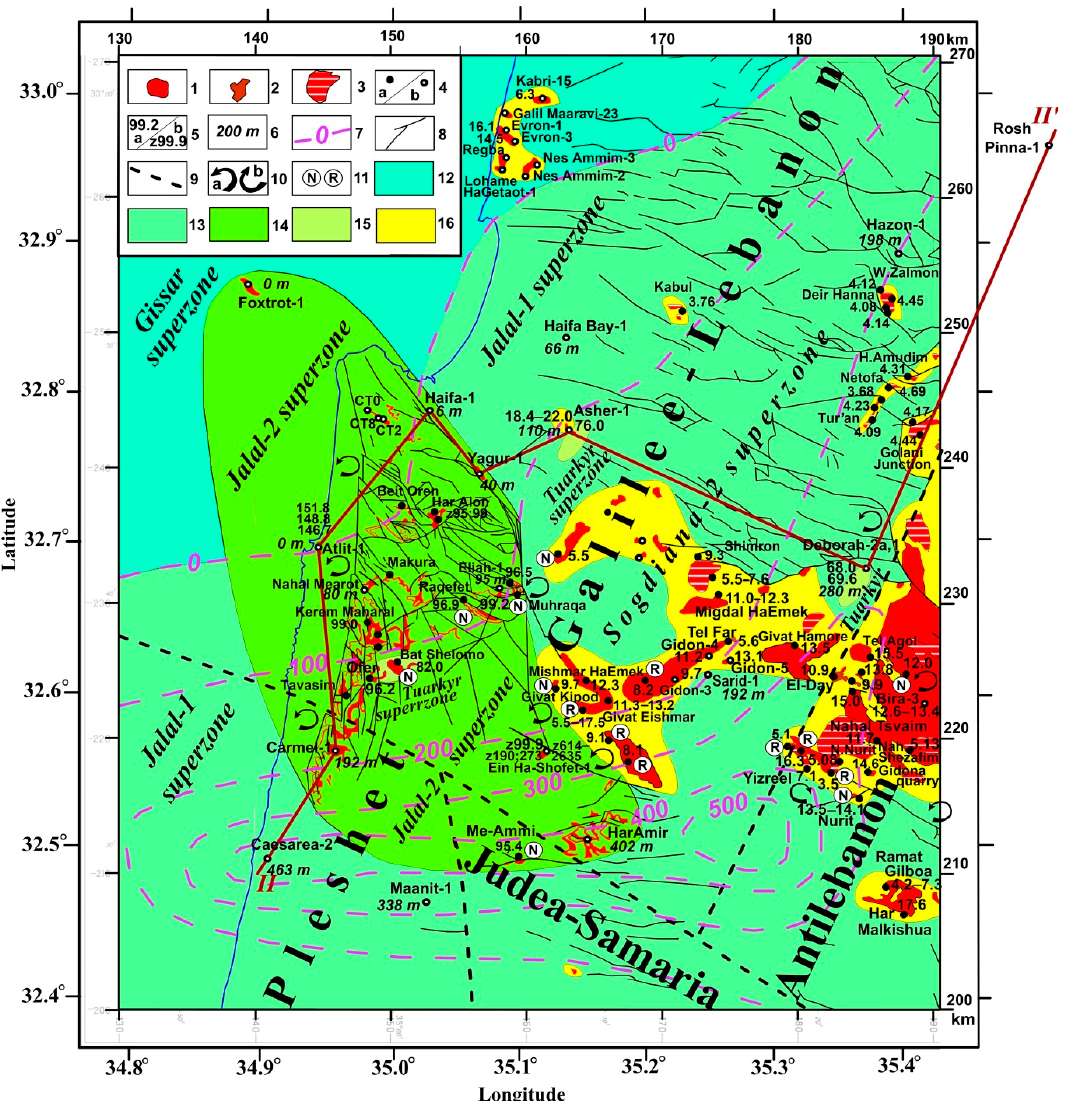
Figure 2. Geodynamic-paleomagnetic map of the Mt. Carmel—Galilee region, CA (see its location in Figure 1). (1) Cretaceous-Miocene basalts, (2) Miocene gabbroid intrusive, (3) Pliocene Cover basalts, (4) outcrops (a) and boreholes (b) with the Mesozoic-Cenozoic magmatic complexes, (5) radiometric age of magmatic rocks and minerals from K-Ar, Ar-Ar methods (a) and zircon geo- chronology (b), (6) thickness of the Lower Cretaceous traps (in m), (7) isolines of the Lower Creta- ceous traps thicknesses (in m), (8) faults, (9) boundaries of terranes, (10) counterclockwise (a) and clockwise (b) rotation derived from tectonic and paleomagnetic data, (11) data of paleomagnetic measurements of magmatic rocks with normal N and reverse R polarities, (12–15) paleomagnetic zones: (12) Gissar, (13) Jalal-1, (14) Jalal-2, (15) Tuarkyr, (16) Sogdiana-2. The bold brown line shows the location of the paleomagnetic profile I–I ′ . The following main works were used for this map construction: [22,23,50,57,64,65,70–88].